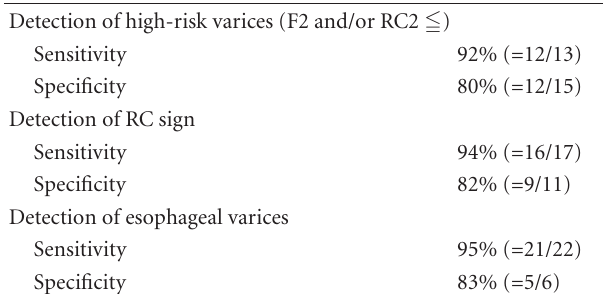
Table 3: Sensitivity and specificity of ECE for diagnosing EV. Detection of high-risk varices (F2 and/or RC2 (cid:2)